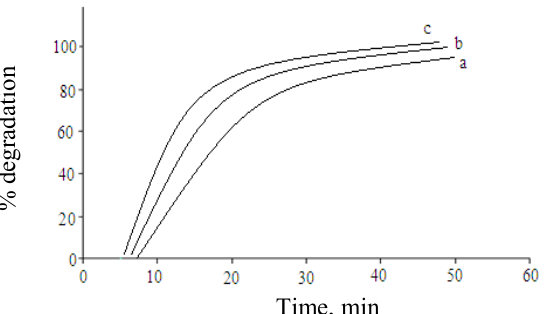
Figure 10. Effect of nature of photocatalyst, a) PbO photocatalyst, b) 3% Ni doped PbO photocatalyst, c) 7% Ni doped PbO photocatalyst.